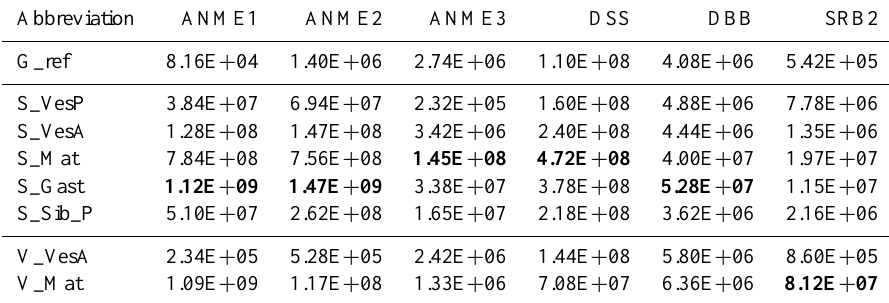
Table 4. Quantitative PCR results for six Archaea and Bacteria phyla potentially involved in the anaerobic oxidation of methane (AOM): ANME1, ANME2, ANME3, DSS, DBB and SRB2. Results are cumulated across the 0–10cm sediment layer and expressed in 16S rRNA copy number per gram of sediment. The highest values for each group of AOM micro-organisms are shown in bold.